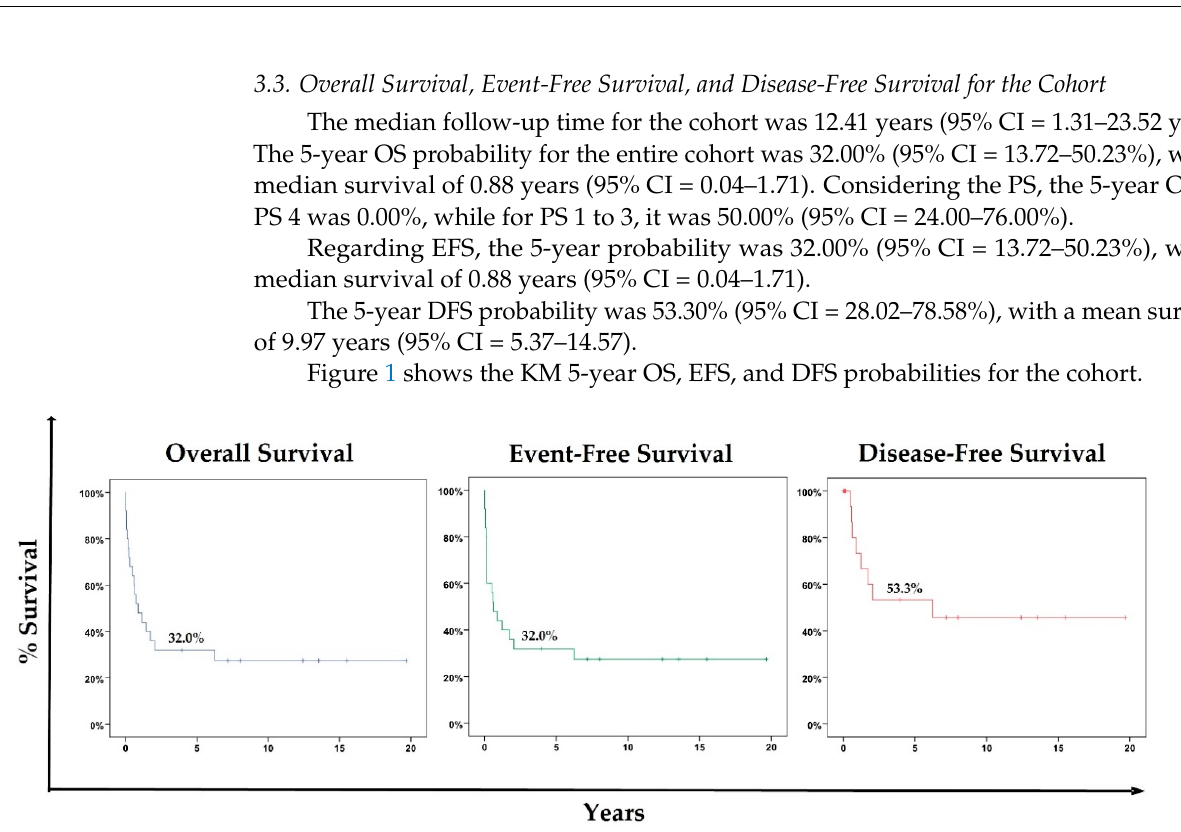
Figure 1. Five-year Kaplan–Meier (5-year KM) OS, EFS, and DFS probabilities for the cohort. The HRs for the Cox proportional hazards models (uni- and multivariate analyses and multivariate analysis of imputed dataset) for death (OS) and event (EFS and DFS) occurrences are shown in Table 2, Table 3, and Table 4, respectively. Table 2. Hazard ratio (HR) for death (OS) (Cox proportional hazards models). Univariate Multivariate Multivariate Analysis of Imputed